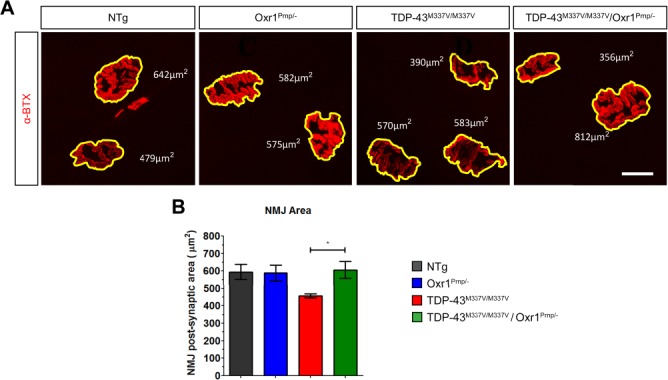
Over-expression of Oxr1 improves post-synaptic NMJ integrity in TDP-43M337V/M337V mutants. (A) Representative images of motor endplates used to measure post-synaptic area from male NTg, Oxr1Prnp/−, TDP-43M337V/M337V and TDP-43M337V/M337V/Oxr1Prnp/− mice at 18 months of age. (B) Average motor endplate area is reduced in TDP-43M337V/M337V mice, and is rescued by over-expression of Oxr1. Values are shown as the mean ± SEM. N = 3–6 each genotype, N = 30–50 NMJs per mouse. *P < 0.05; one-way ANOVA with Dunnett’s multiple comparison test comparing each group to TDP-43M337V/M337V mice. Scale bar: 20 μm.